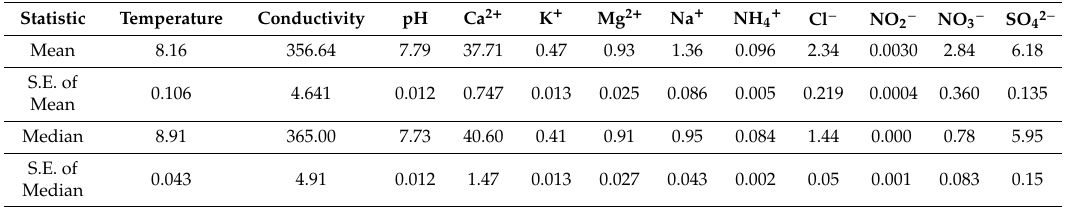
Table 2. Basic statistics for measured variables, using stratified estimates (caves and months define the strata). There were 35 strata and 252 observations. All concentrations are in mg / L. Conductivity is in µ S / cm. Temperature is in ◦ C.